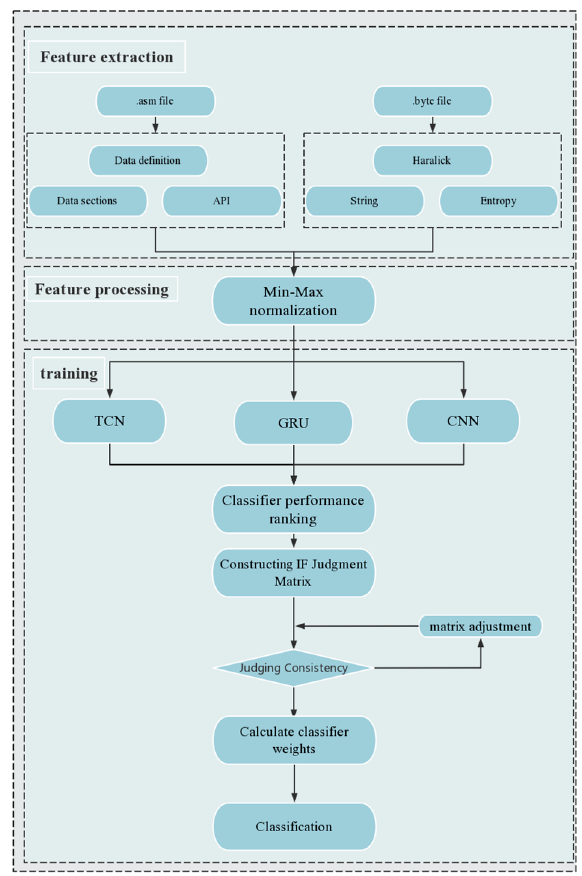
Figure 5. The malware classification model structure.